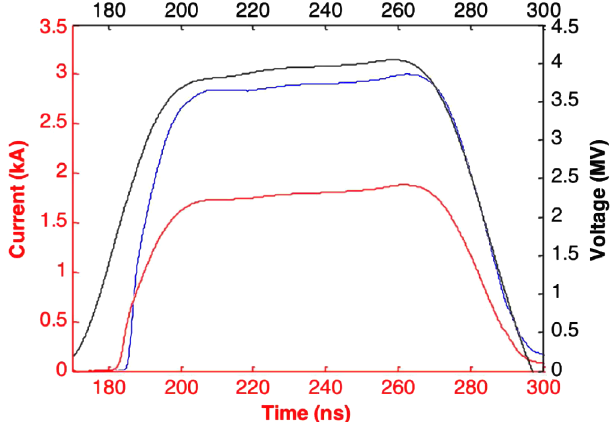
FIG. 2. Measured Blumlein voltage (black) used to extract the measured electron beam current for the 5 cm cathode (red) and the 7 cm cathode (blue). Each current was measured at BPM02, 82 cm downstream of the cathode